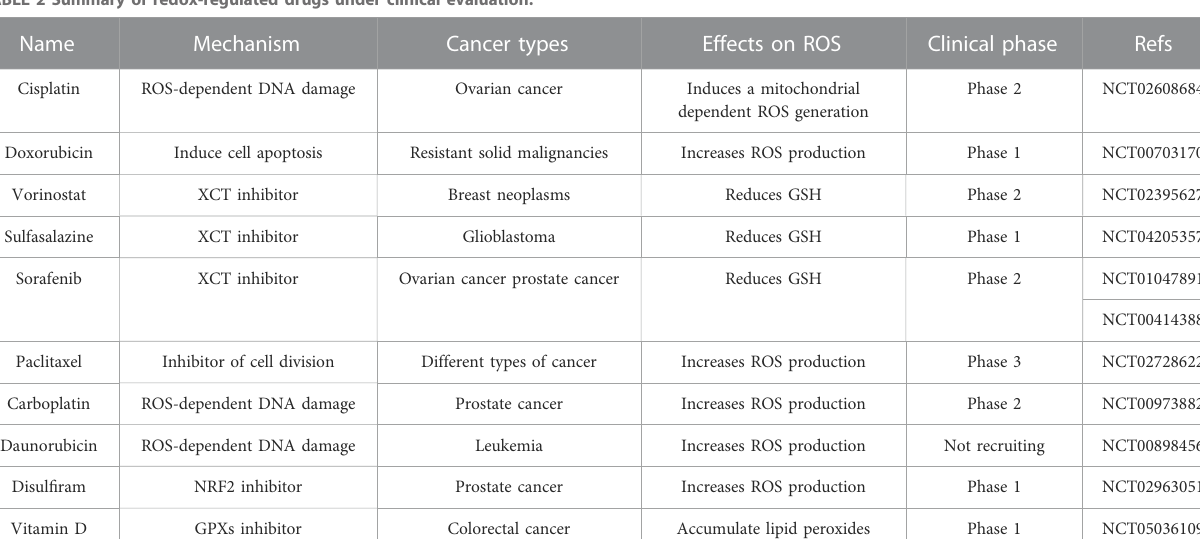
TABLE 2 Summary of redox-regulated drugs under clinical